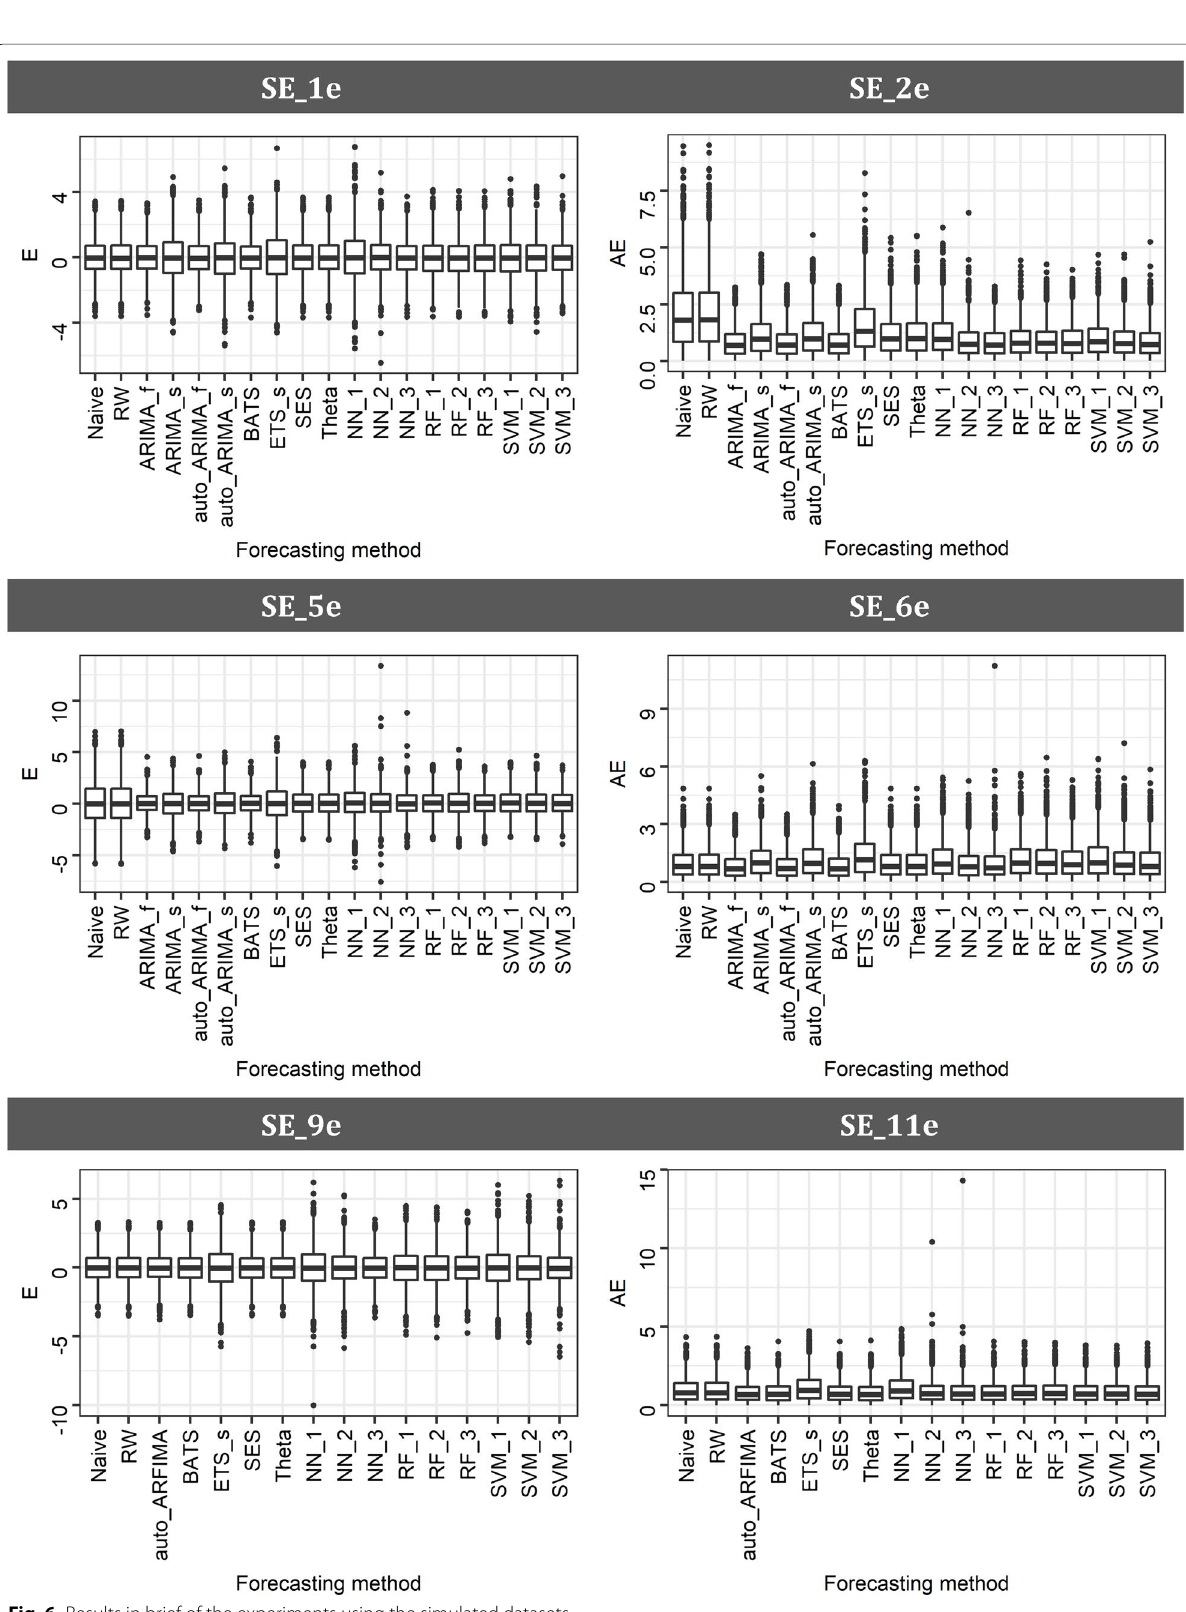
Fig. 6 Results in brief of the experiments using the simulated